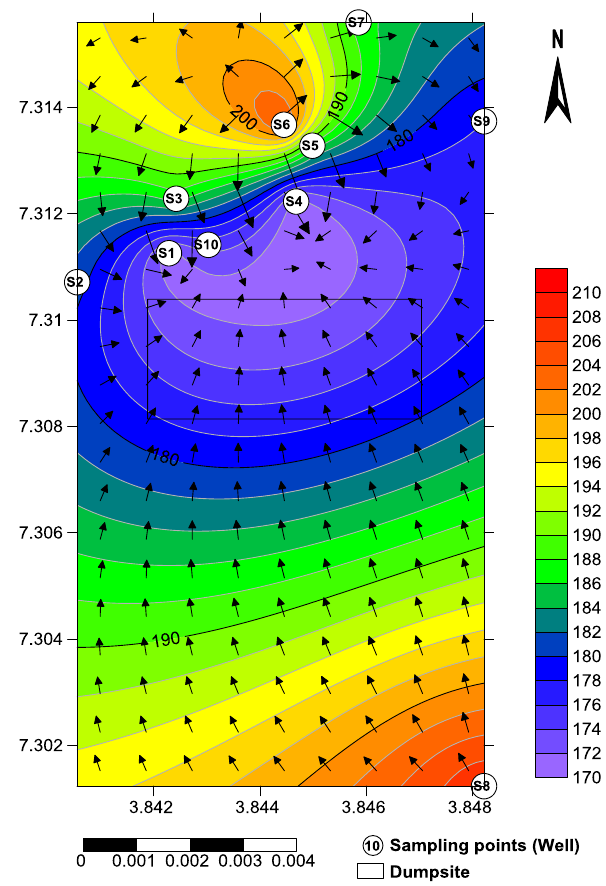
Fig. 3 Potentiometric map showing the groundwater flow direction with respect to dumpsite